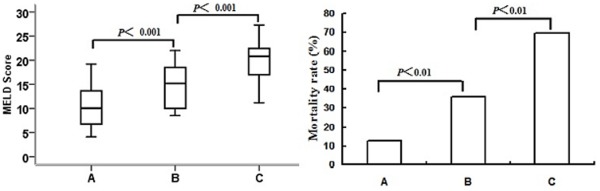
Comparisons of the Model for End-stage liver disease (MELD) score (left) and mortality rate (right) among patients with different red cell distribution width (RDW) values.Patients were divided into three groups based on serum RDW values: group A (≤15.0%), B (>15.0%, but <20.0%) and C (≥20.0%).